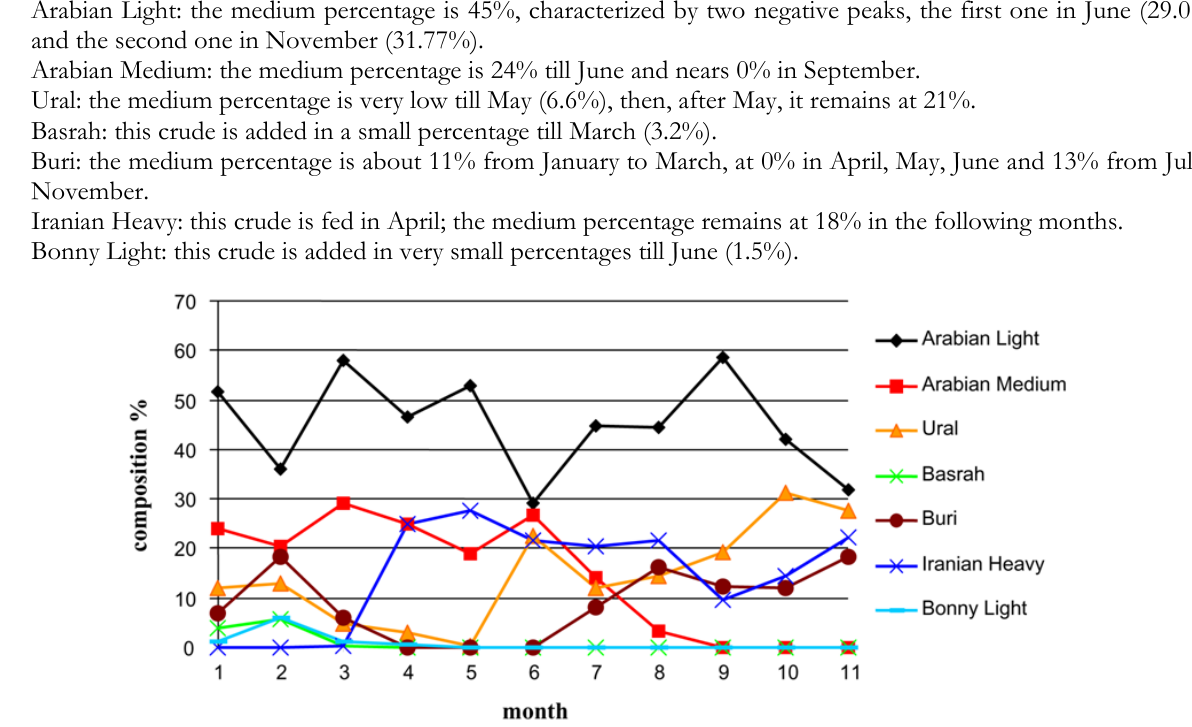
Figure 2: Crude composition (weight %) during the last operating year.